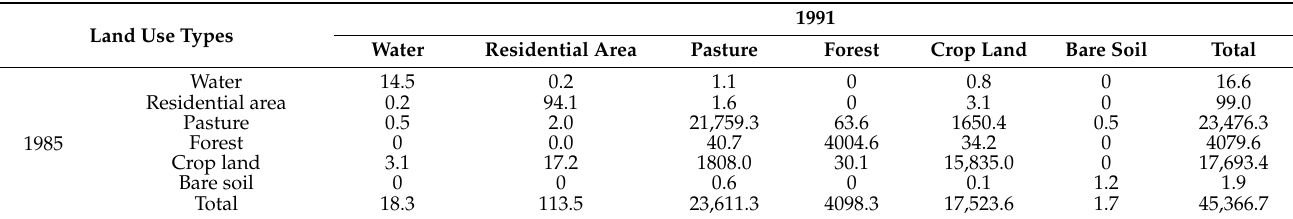
Table 2. LUCC transfer matrix of the JRB from 1985 to 1991 (area:km 2 ).